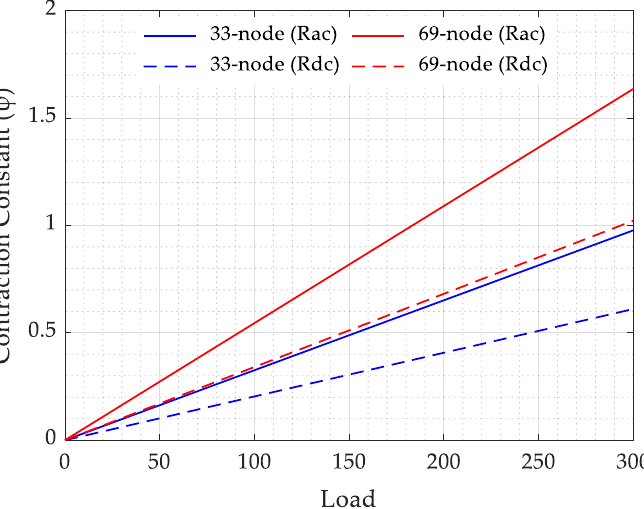
Figure 13. Maximum allowable loading with R ac and R dc in terms of a contraction constant.